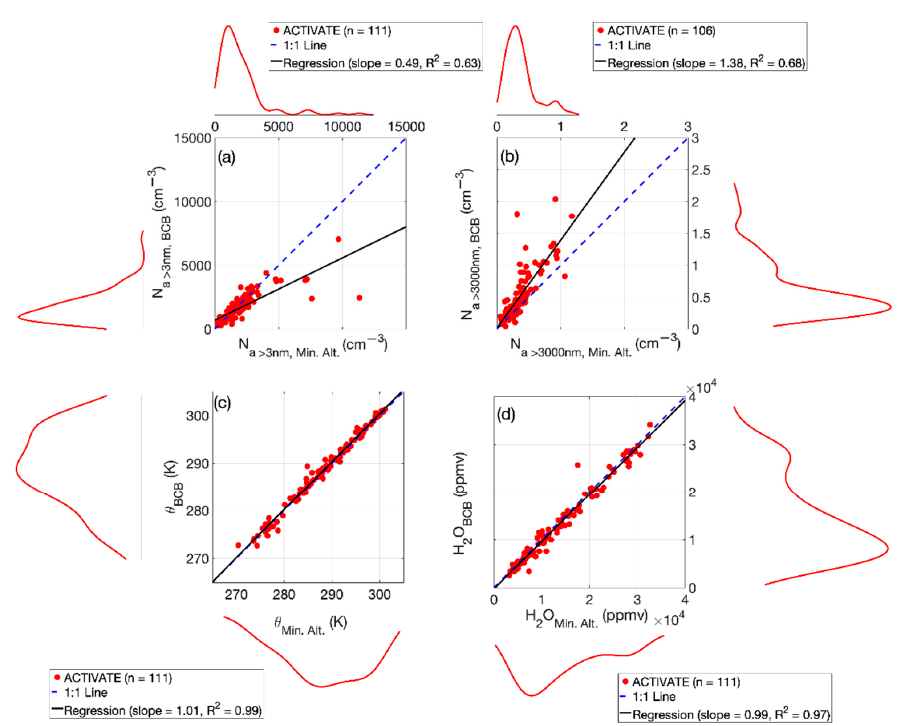
Figure 4. Scatterplots of leg-mean values for selected variables measured in BCB and Min. Alt. legs in cloud ensembles during 2020 ACTIVATE flights. The plots on the sides are marginal distributions based on Kernel density estimation. An analogous figure for clear ensembles in ACTIVATE can be found in Figure S2.